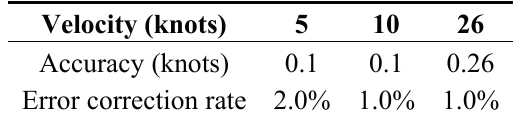
Table 3. Velocity accuracy and error correction rate.